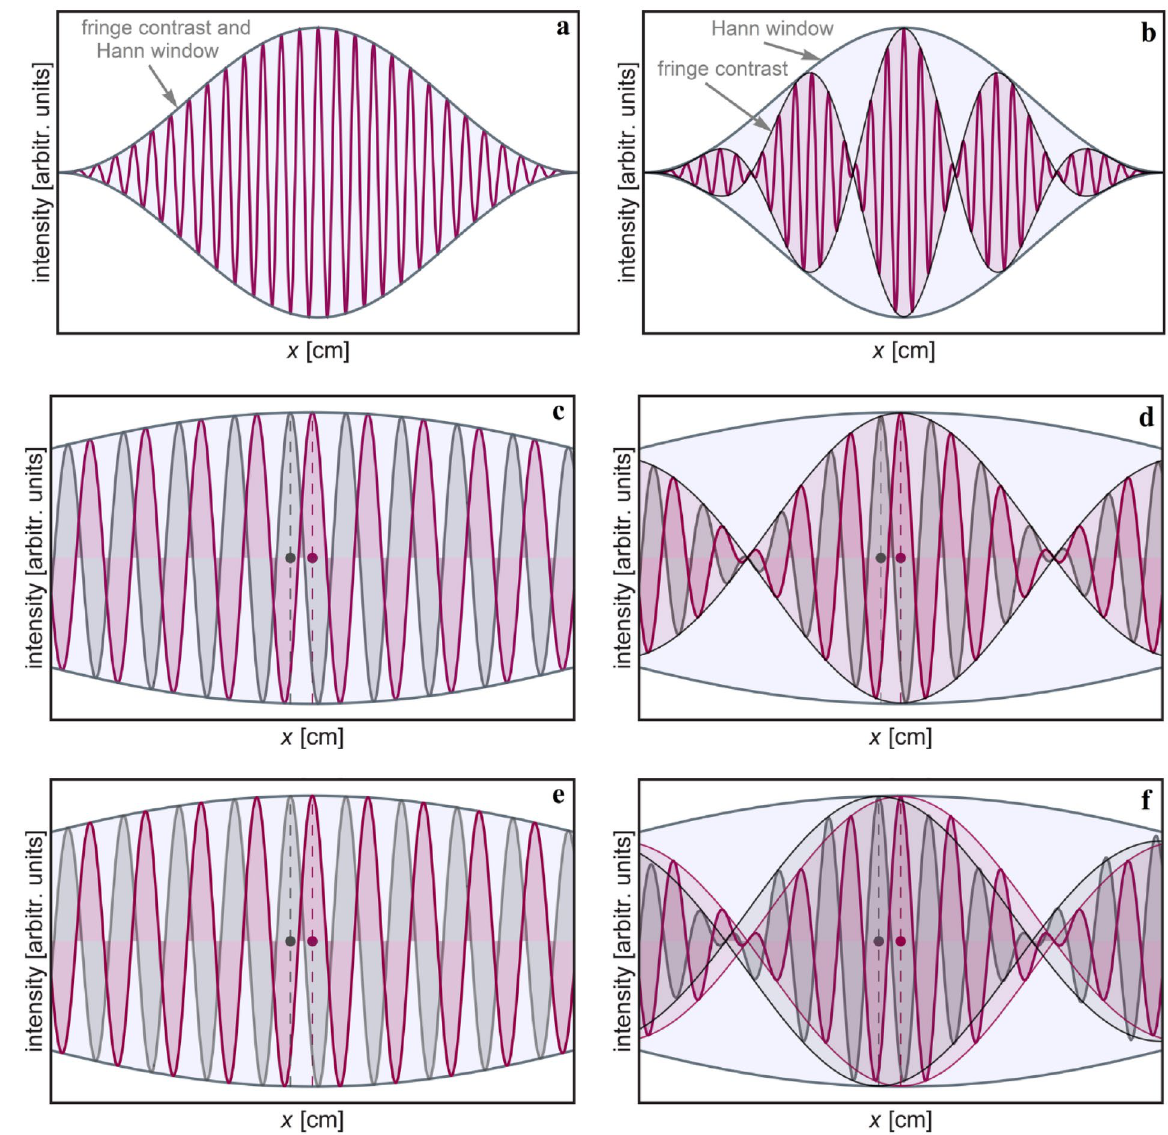
Figure 2. Theoretical simulation of a monochromatic ( a ) and polychromatic ( b ) apodized interferogram, respectively. The Hann apodization window envelope and interference fringes envelope (i.e., fringe contrast) are also depicted. The effect of the geometric phase shift on a monochromatic and polychromatic wave, respectively, is described in ( c ) and ( d ). Similarly, the effect of the dynamic phase shift on the same monochromatic and polychromatic waves is shown in ( e ) and, ( f ). In the monochromatic wave scenario, there are similar results for the two kinds of phase shift. In the case of a polychromatic wave, the geometric phase shift only modulates the interference fringes but with no translation of the fringe contrast